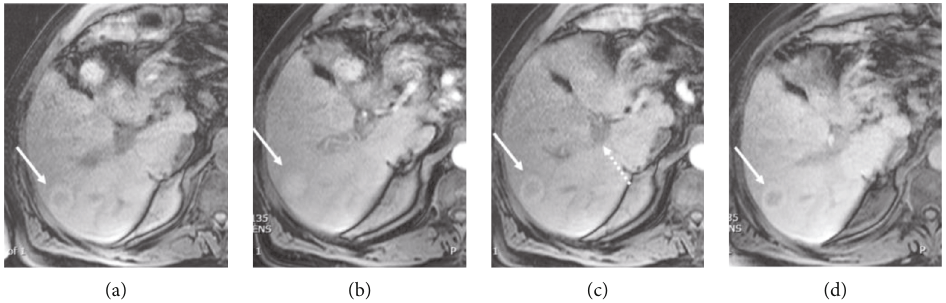
Figure 1: MRI with Eovist® (gadoxetate disodium contrast) shows the persistent portal vein thrombosis (dotted arrrow) and the segment 7 lesion (solid arrow). The lesion measures 2.6cm and is faintly hypointense with hyperintense rim on precontrast T1W image (a), enhances centrally on arterial phase (b), central washout with a persistent hyperintense rim on portal venous phase (c), and no Eovist® uptake centrally with a persistent hyperintense rim on hepatocyte phase. This appearance is suspicious for